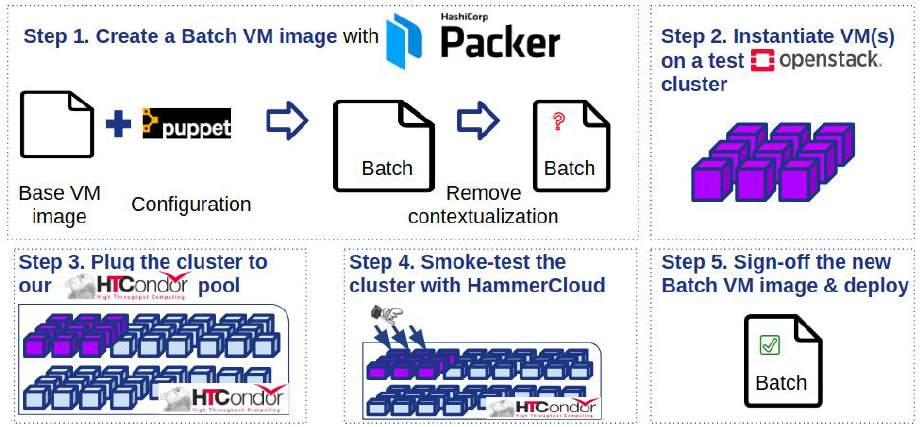
Fig. 3. Steps to create and validate a batch VM image, using the CERN batch CI/CD suite.